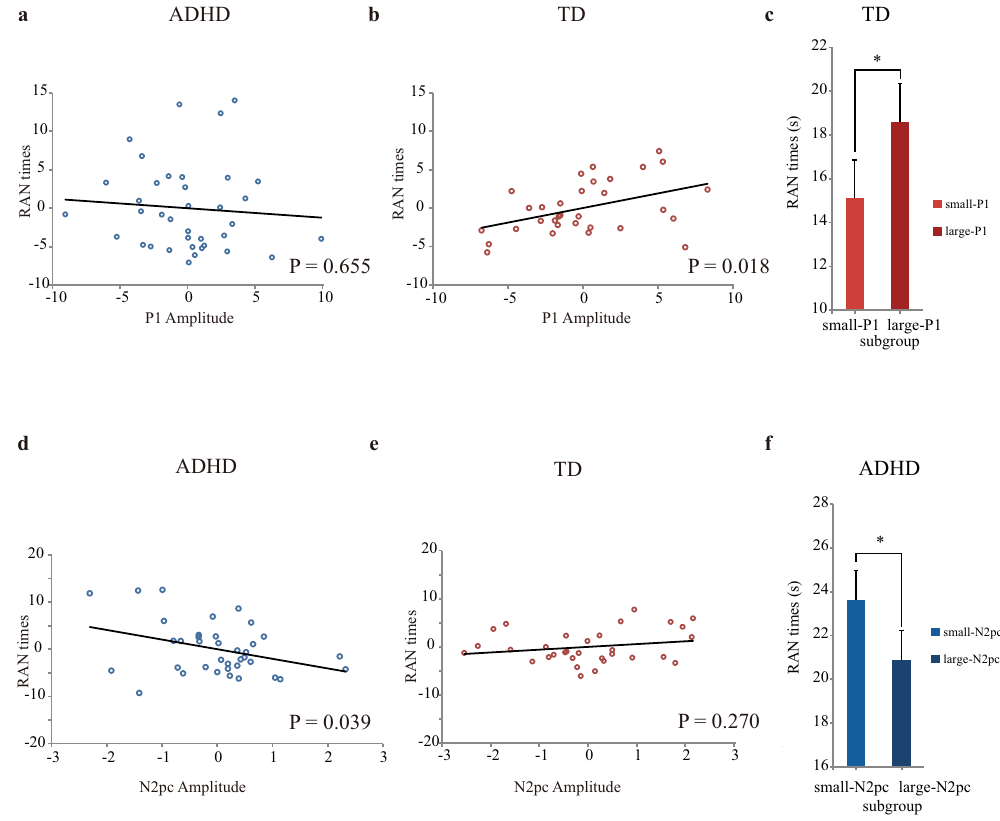
Figure 3. Scatter plots depict regression results between P1 amplitude and RAN times in children with ADHD ( a ) and TD children ( b ) after controlling for age and IQ. The schematic illustration in ( c ) shows mean times (and SE) of RAN for small-P1 and large-P1 subgroups for TD children. Scatter plots depict regression results between target-elicited N2pc amplitude and RAN times in children with ADHD ( d ) and TD children ( e ) after controlling for age, IQ and N2pc latency. The schematic illustration in ( f ) shows mean times (and SE) of RAN for small-N2pc and large-N2pc subgroups for children with